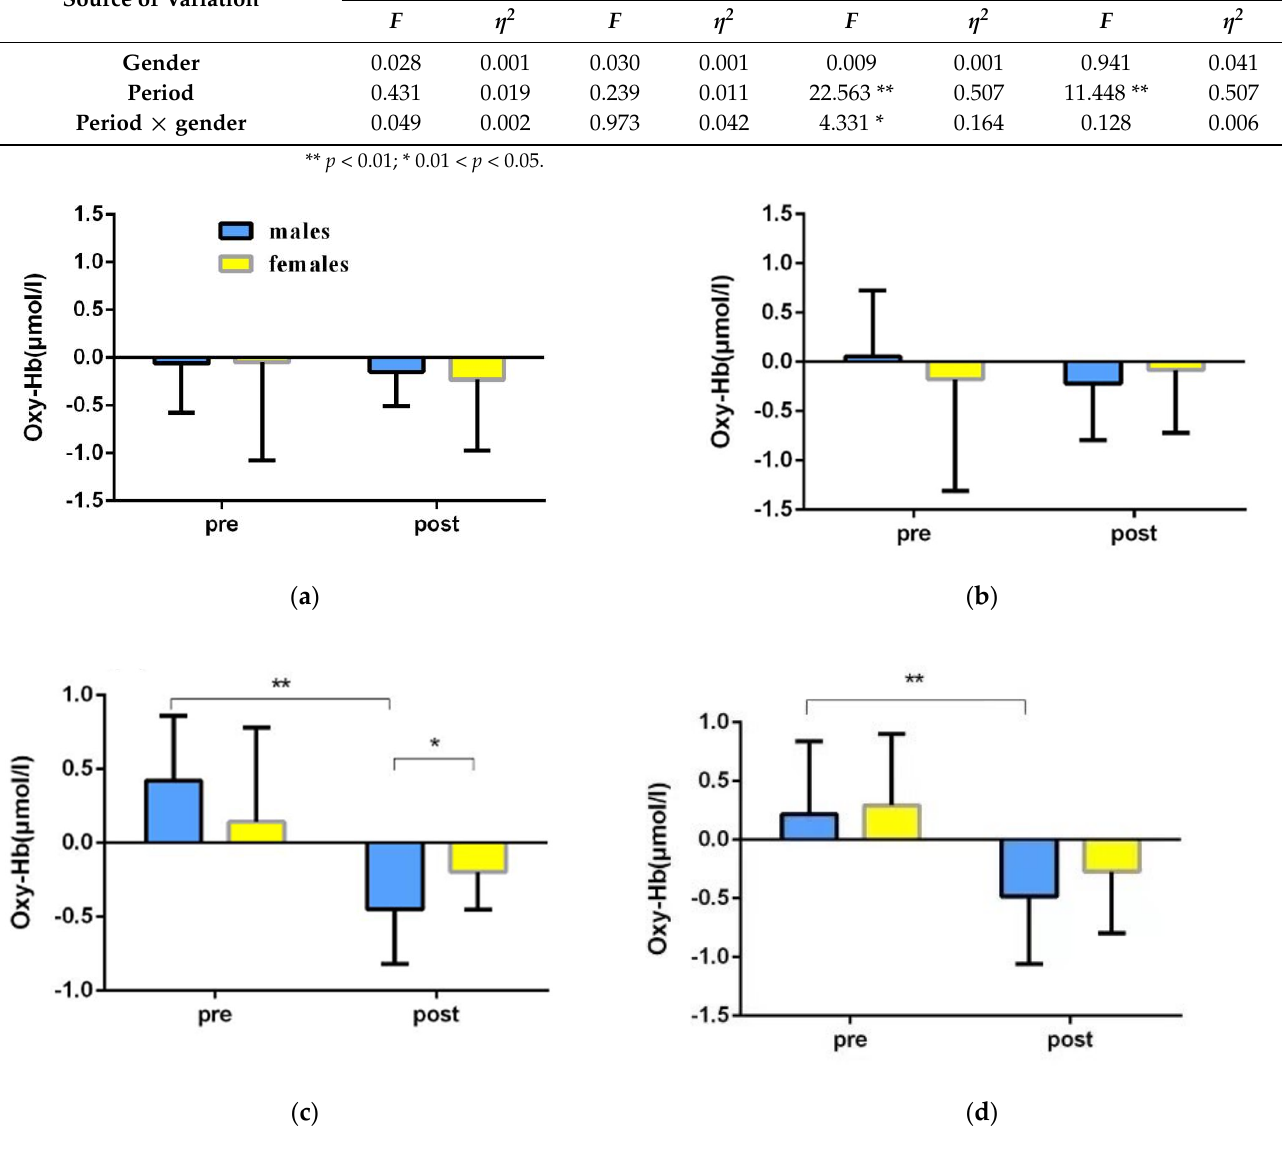
Figure 9. Changes in the fNIRS results of spatial memory of college students of different genders before and after orienteering intervention in the experimental group. Before and after orienteering intervention in the experimental group. ( a ) L ‐ VLPFC; ( b ) R ‐ VLPFC; ( c ) L ‐ DLPFC; ( d ) R ‐ DLPFC) represent the changes of Oxy ‐ Hb concentration in college students of different genders. * 0.01 < p < 0.05; ** p < 0.01.